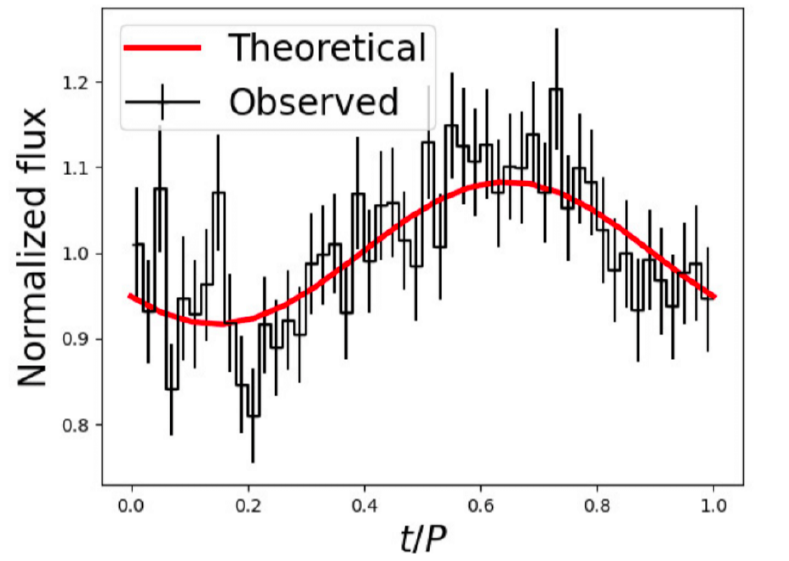
Figure 6. Phase diagram for the set of best parameters calculated in the posterior of the MCMC